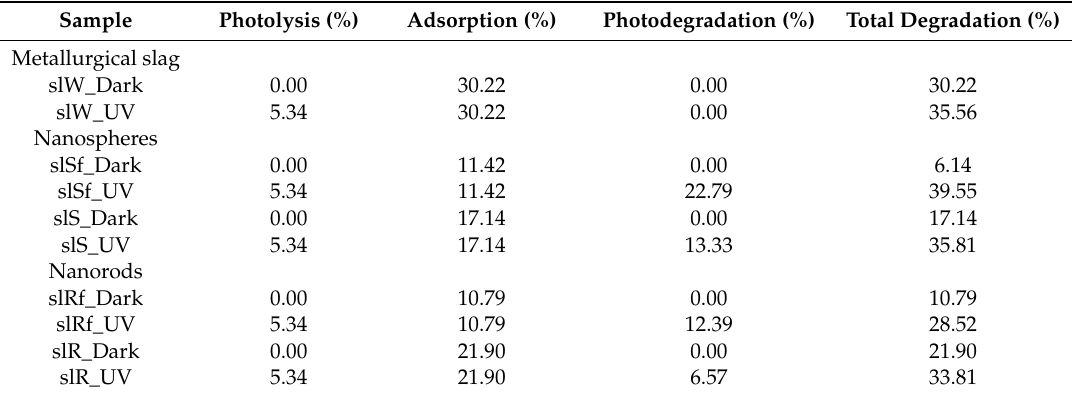
Table 2. E ff ects in the photodegradation process in metallurgical slag-based